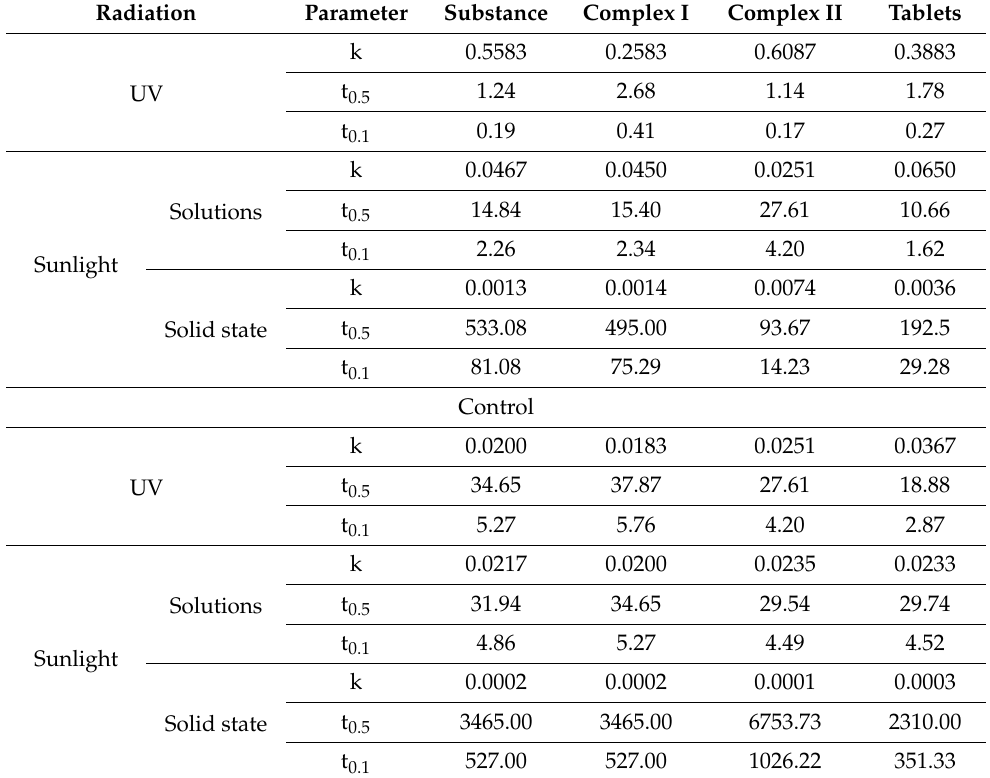
Table 3. Values of kinetic parameters for irradiated